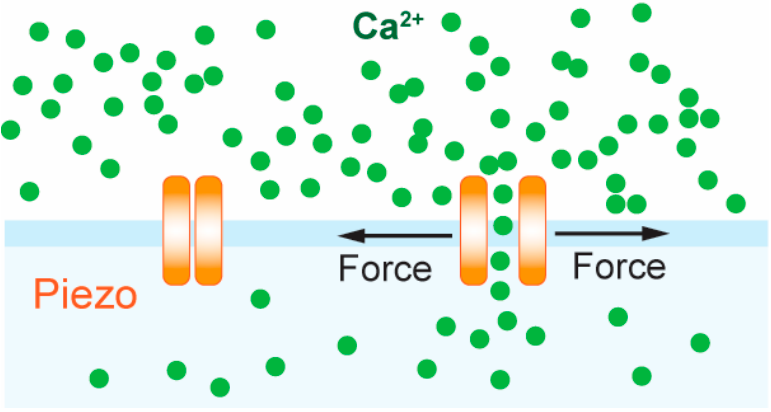
Figure 4. T cell activation by Piezo. Illustration depicting how force exerted on Piezo can induce entry of calcium flux resulting in T cell activation.